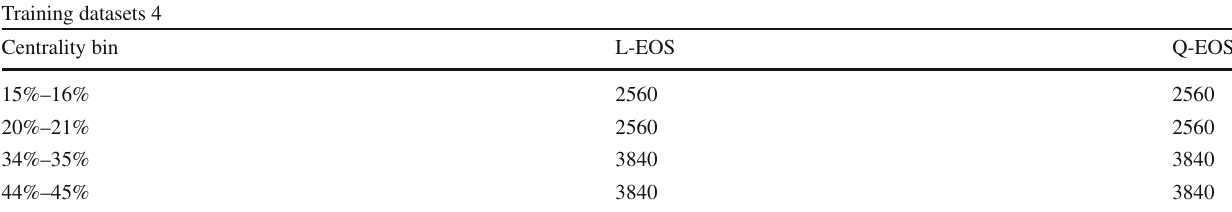
Table 6 Training datasets 4: numbers of event-by-event spectra ρ( p ,(cid:6)) computed by the iEBE-VISHNU hybrid model with the MC- T Glauber initial conditions in the centrality range 0–50%. The ratio of